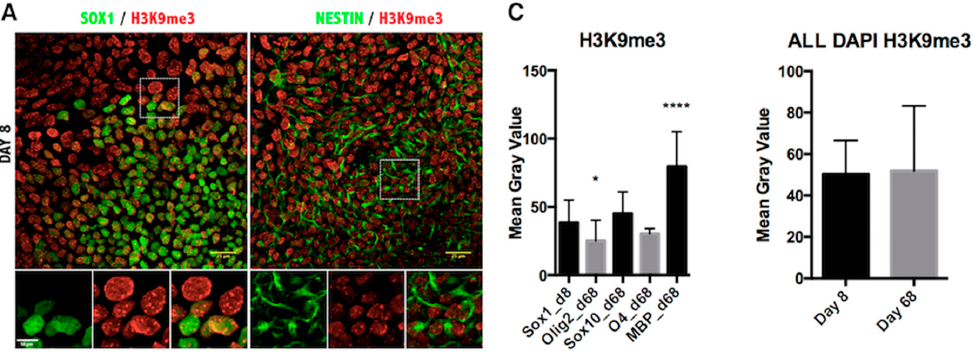
Figure 4. Immunofluorescence analysis of histone H3 lysine 9 acetylation in iPSC-derived oligodendrocyte lineage cells. ( A ) Representative images of Day 8 of the oligodendrocyte differentiation protocol co-stained for NSC markers SOX1, NESTIN and the H3K9ac antibody; ( B ) Images from Day 68 of differentiation co-stained for oligodendrocyte markers OLIG2, SOX10, O4, MBP and H3K9ac antibody. Scale bar = 25 µm. The magnified view of the broken line box area appears as the inset with the individual channels and the merged image. Scale bar = 10 µm; ( C ) Quantitation of the immunofluorescence signal as the mean gray value in cells expressing the indicated markers ( left ) or in all DAPI-positive cells per field ( right ). Results are represented as the mean with the SD. **** p < 0.0001.